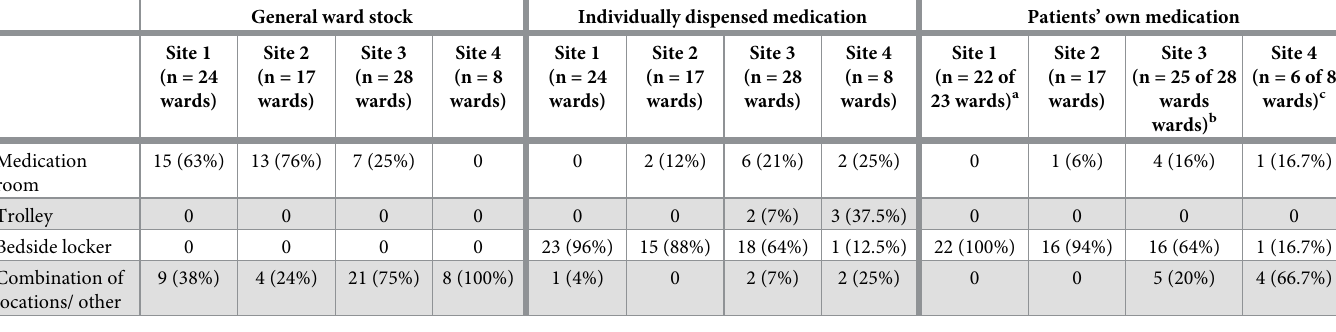
Table 2. Primary storage locations for ward stock, individually dispensed medication and patients’ own medication on all wards across the four hospital